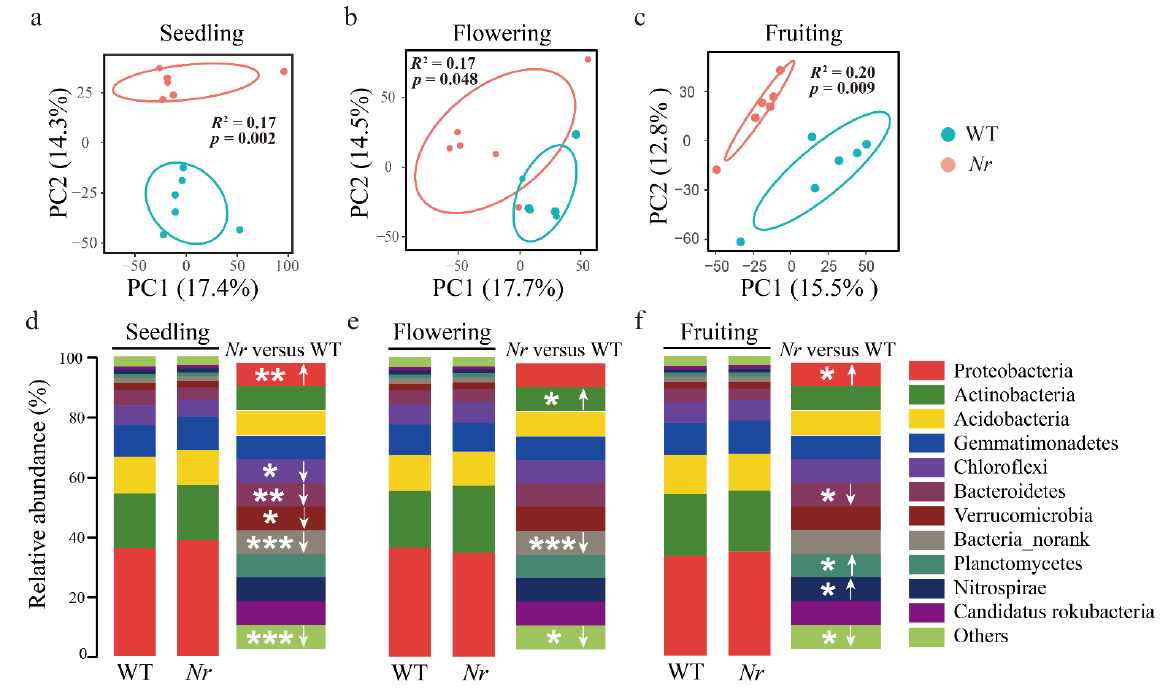
Figure 2. Bacterial community structure in the rhizosphere of WT and Nr tomato plants. Principal component analysis (PCA) of the rhizosphere bacterial communities of WT and Nr plants at the seedling ( a ), flowering ( b ), and fruiting ( c ) stages. Bar chart displaying the relative abundances of bacterial phyla in the rhizosphere of WT and Nr plants at the seedling ( d ), flowering ( e ), and fruiting ( f ) stages. Two-sided Student’s t -test (upward and downward arrows indicate significant increases and decreases in taxa relative abundances, respectively), * indicates p < 0.05, ** indicates p < 0.01 and *** indicates p < 0.001.